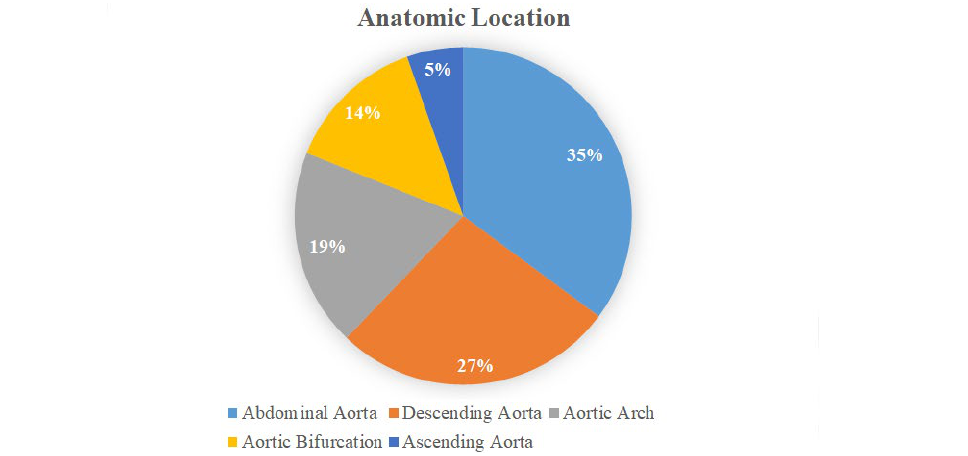
Figure 3. The anatomic distribution of aortic thrombus among patients COVID-19